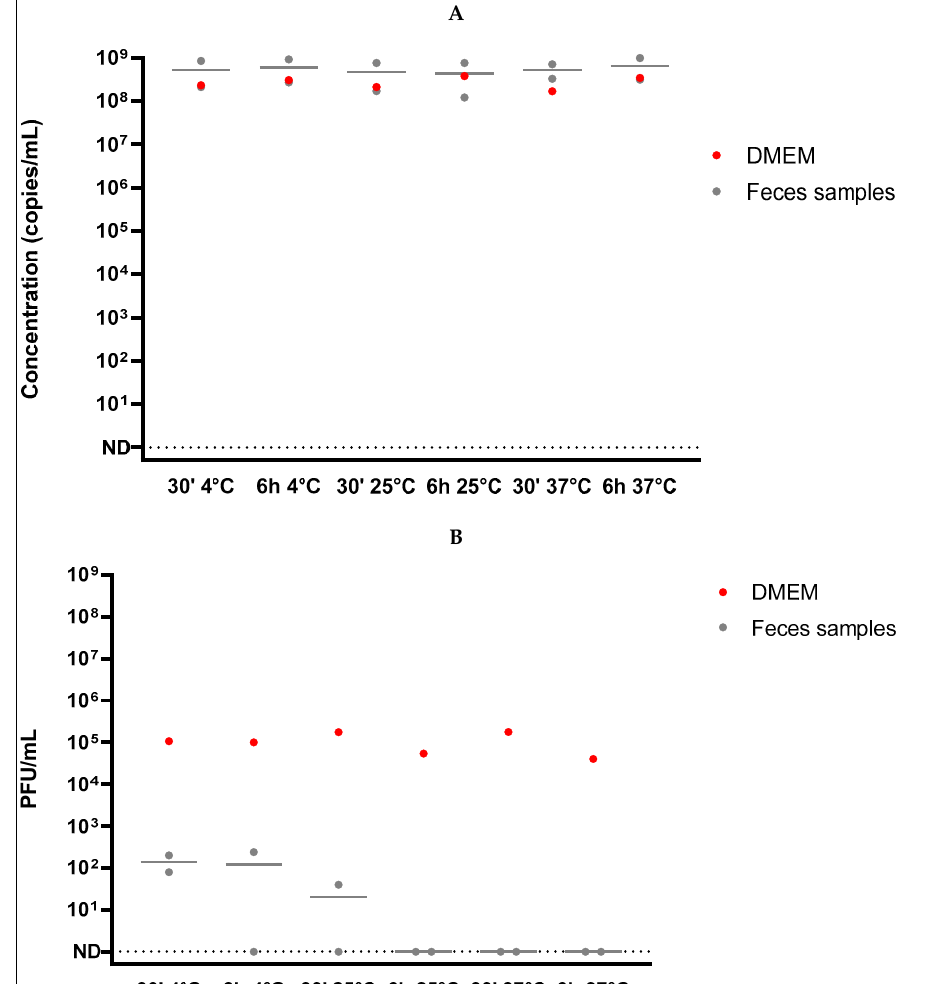
Figure 4. Persistence of SARS-CoV-2 in hamster feces at different incubation temperatures up to 6 h. ( A ) Viral RNA measured by RT-qPCR in hamster’s feces sample spiked with infectious virus (grey) was compared to virus incubated in cell culture medium (red) and did not show any change in RNA concentration after 6 h incubation at 4 °C or 37 °C. ( B ) Infectivity evaluation of SARS-CoV-2 particles by endpoint plaque assay after incubation in hamster’s feces (grey) and cell culture medium (red) was done. In these conditions, a decrease in infectivity was observed in time- and temperature-dependent manner.